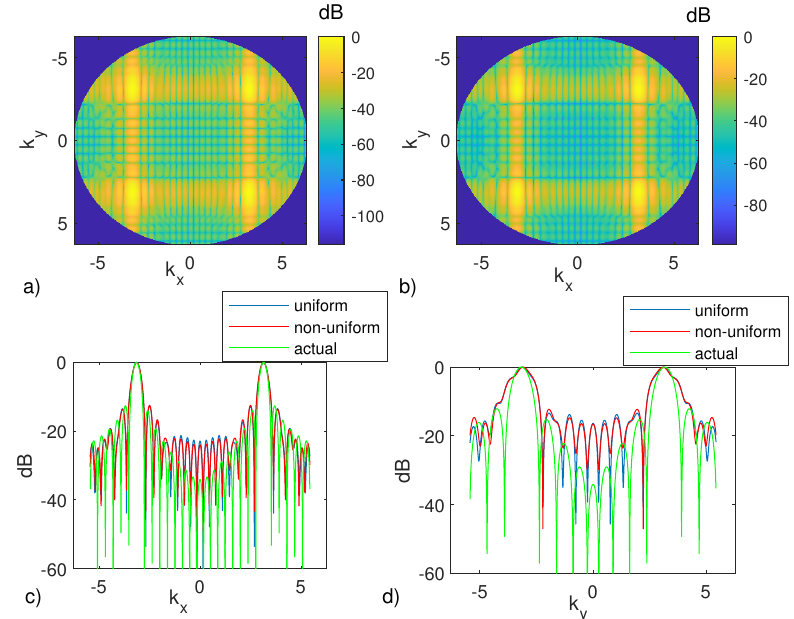
Figure 9. Normalized amplitude of the radiation pattern of J 3 ( x , y ) with X s = 8 λ , Y s = 4 λ , z o = 7 λ